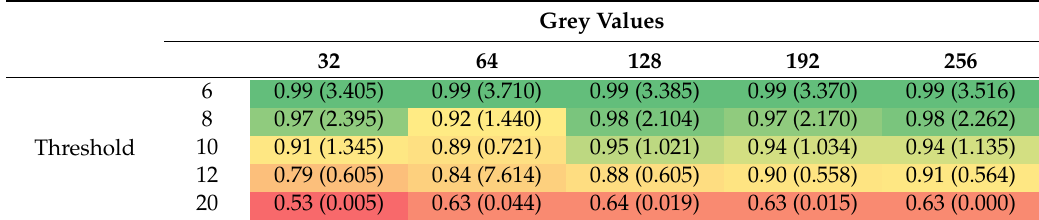
Table 5. Proportion of the manual reef area shared with the model-predicted one after the method proposed by [23] under di ff erent frame conditions. Color scale indicates high values in green and low values in red. The predicted reef area [km 2 ] not shared with the manually derived one ( = 8.675 km 2 ) is given in parentheses.